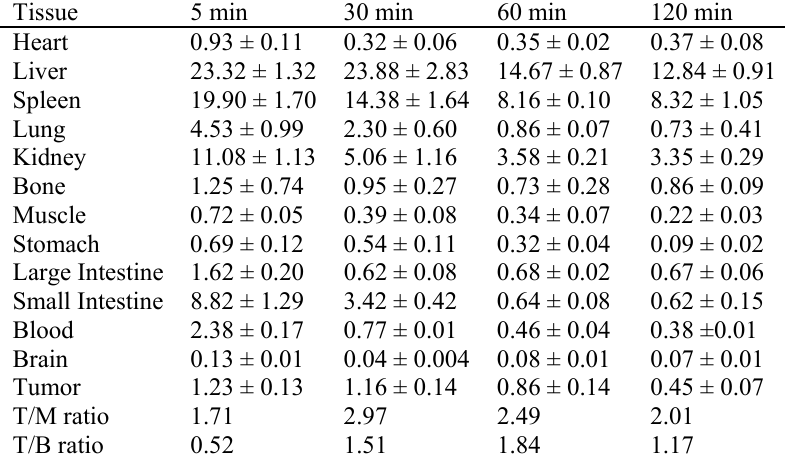
Table 2. Biodistribution of 99m TcN-MAG-ABCPP in mice bearing S 180 tumor (%ID/g) a . Tissue